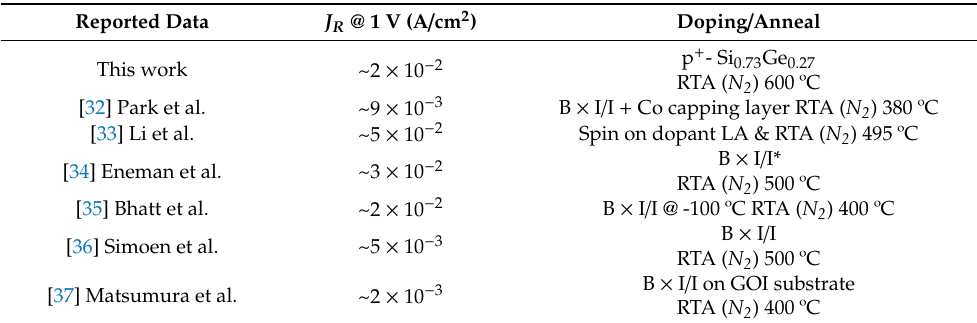
Table 2. Leakage current density comparison between a 10 4 µ m 2 diode fabricated with selective epitaxy (this work) and other published data of similarly sized diodes (where that information was available). The reverse current values were graphically extracted at